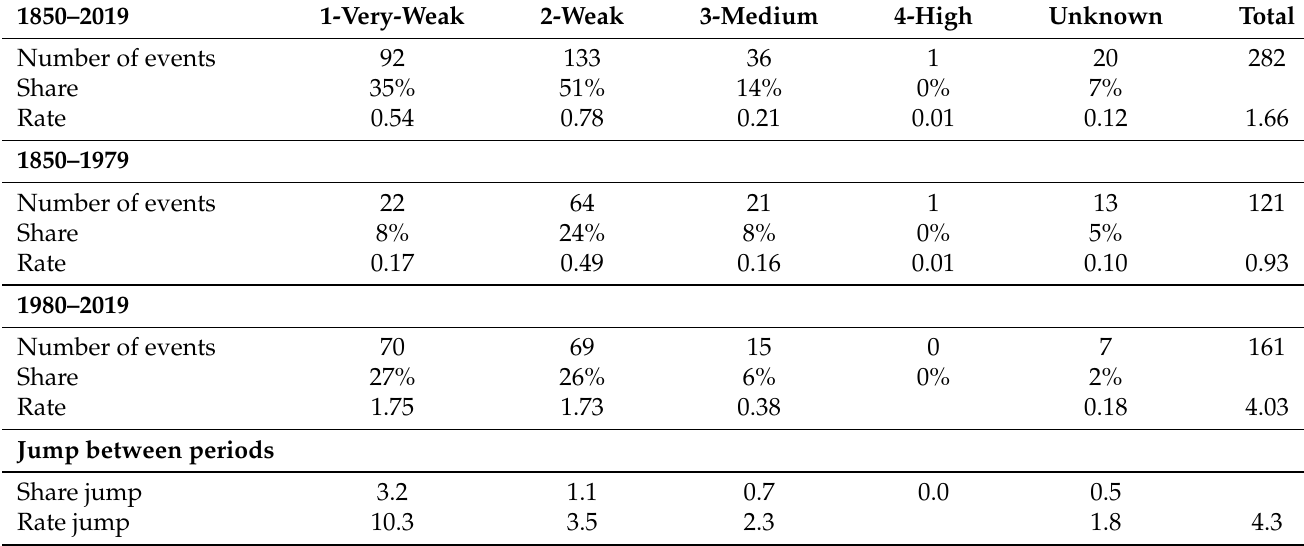
Table 3. Number of flood events that occurred on the 139 torrential sites of the Metropolitan area over three different periods of time (first sets of rows) and for five flood intensity levels (columns— “Unknown” means that the intensity is not qualified). The shares represent the percentage of qualified events for each intensity (1- to 4-) and the percentage of not qualified events (Unknown). The rates represent the number of events per year over the period or slope of the cumulative curve. Separate counts are given for the events dated to the day and for the different intensities. The last set of rows gives the ratios of shares and rates between the two